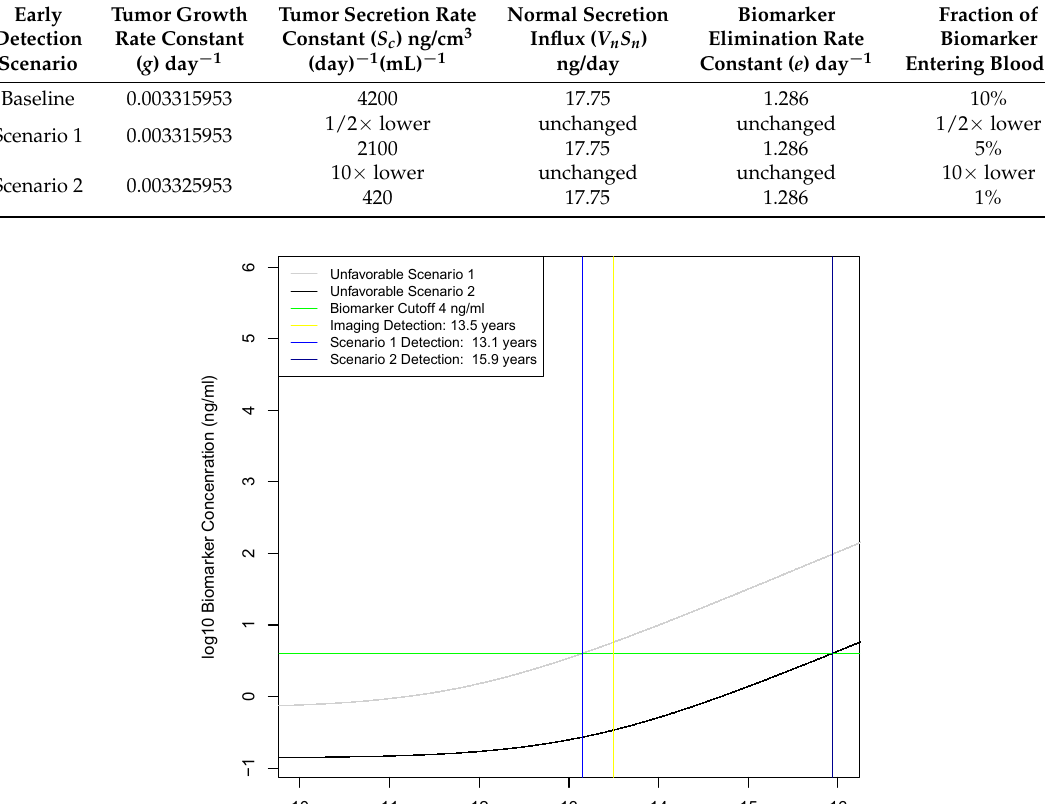
Table 4. Two-way Parameter Variation Scenarios.